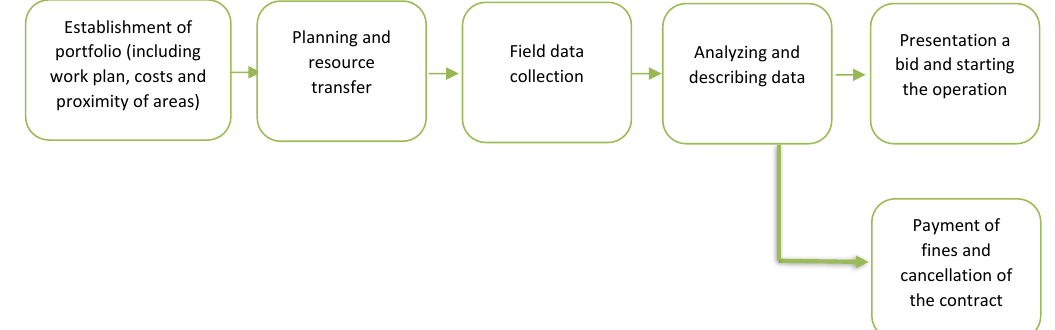
Fig. 4: The process after the auction until the end of the Fig. 4. The process after the auction until the end of the auction